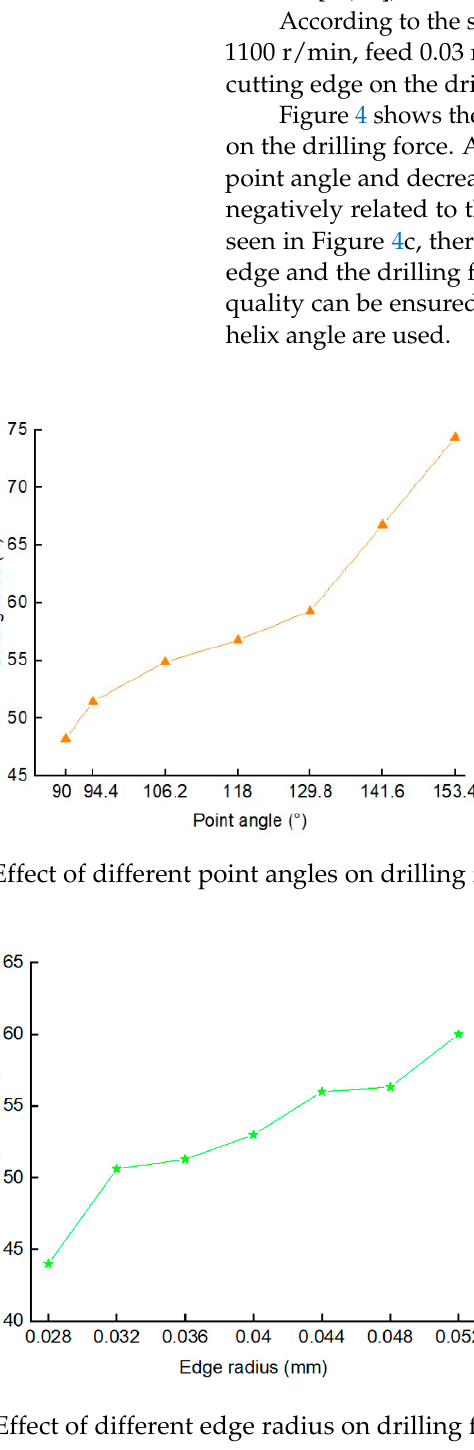
Figure 4. The influences of bit edge shape parameters on drilling force.